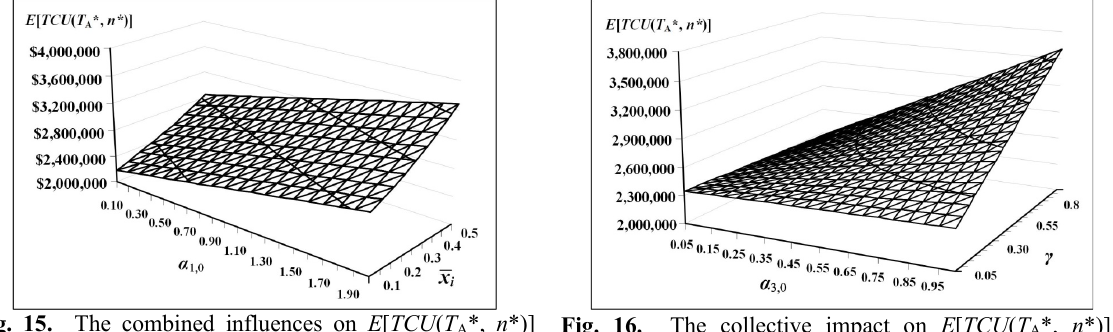
Fig. 16. The collective impact on E [ TCU ( T A *, n *)] concerning α 3,0 and γ